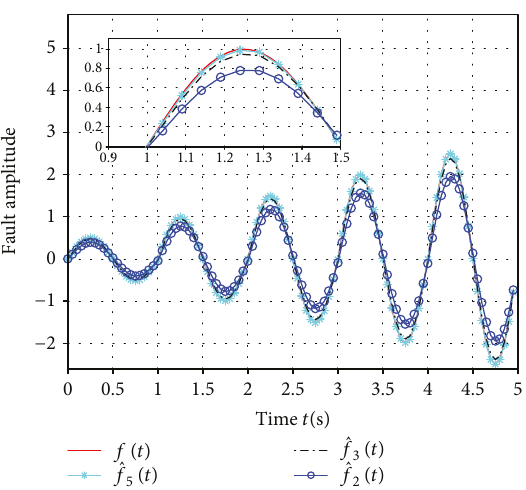
Figure 1: The tracking trajectory of abrupt fault for a nonlinear system with constant parameter